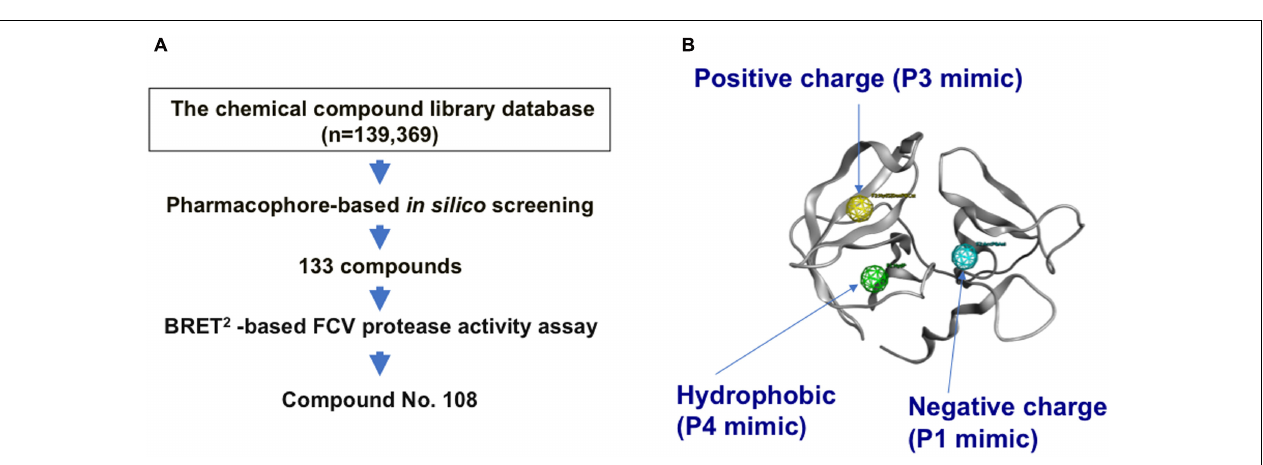
FIGURE 2 | Pharmacophore-based in silico screening for the substrate mimic. (A) Flow chart for in silico screening. A structural model of the FCV protease bound to the FCV F4-6 peptide was constructed by homology modeling and docking simulation. Using the complex model, pharmacophore-based in silico screening (Schuster et al., 2006a,b; Kirchmair et al., 2007) was applied in combination with a cell-based protease activity assay to identify a compound, named No. 108, from a chemical library containing 139,369 compounds. The No. 108 has structural features of an authentic substrate in the protease-bound state and has the ability to inhibit FCV protease activity and viral infectivity in the infected cells (Figures 3, 4) . (B) Pharmacophore mapping on the FCV protease model. An aromatic-ring-like portion resembling the P4 amino acid residue, a positively charged portion resembling the P3 amino acid residue, and a negatively charged portion resembling